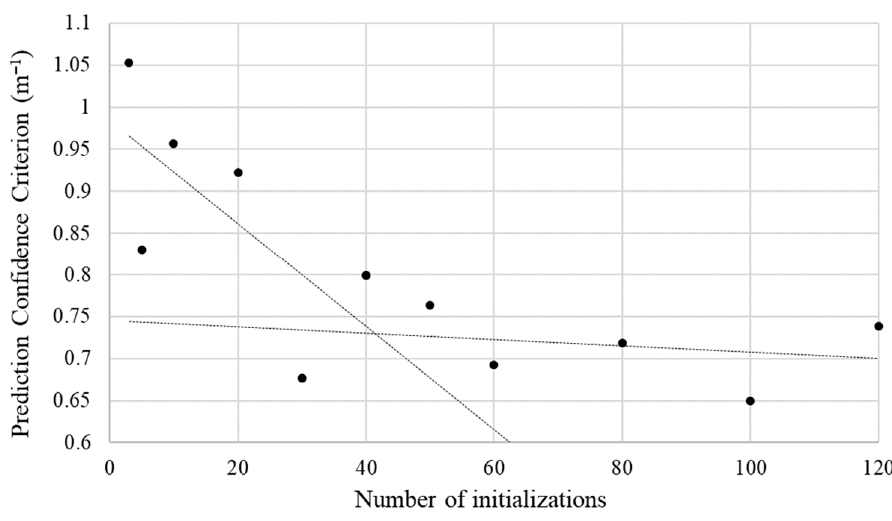
Figure 5. C PC cross-validation score of ensemble models as a function of the number of members ( X ).